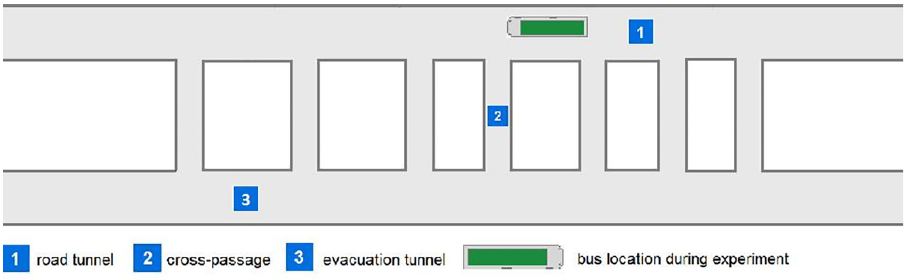
Fig 3. Bus location during experiments 1–2 in the tunnel under the Dead Vistula River in Gda ń sk.